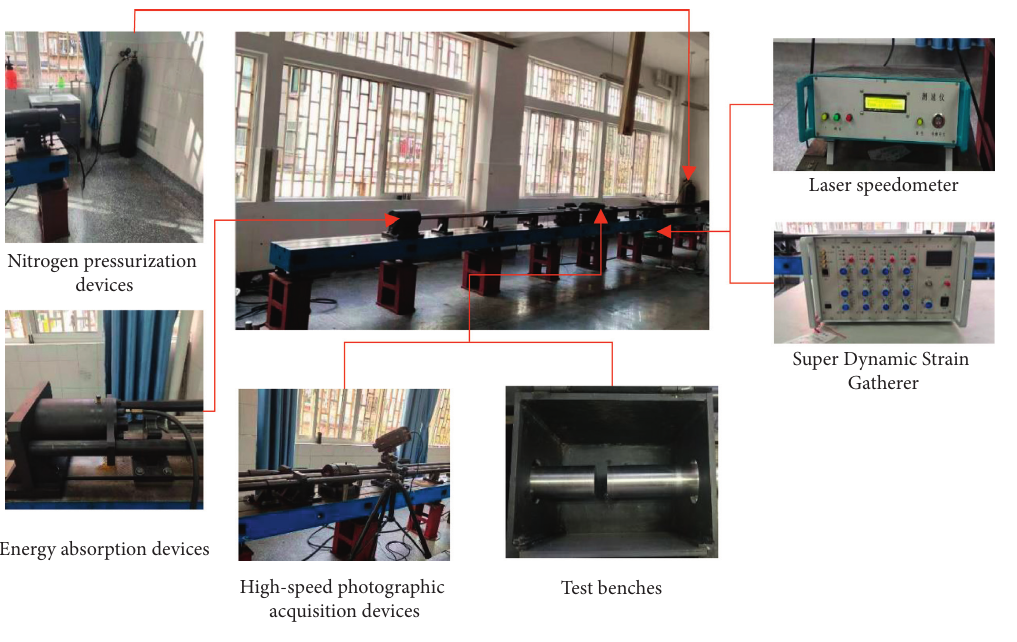
Figure 1: SHPB impact test